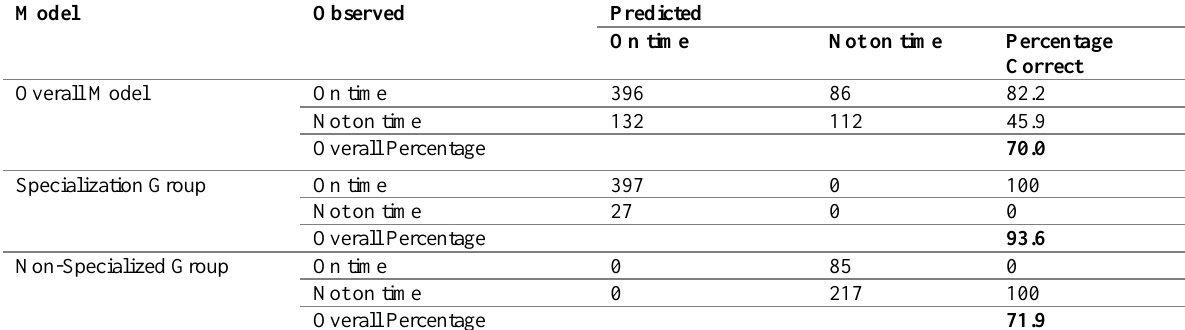
Table 5: Classification accuracy